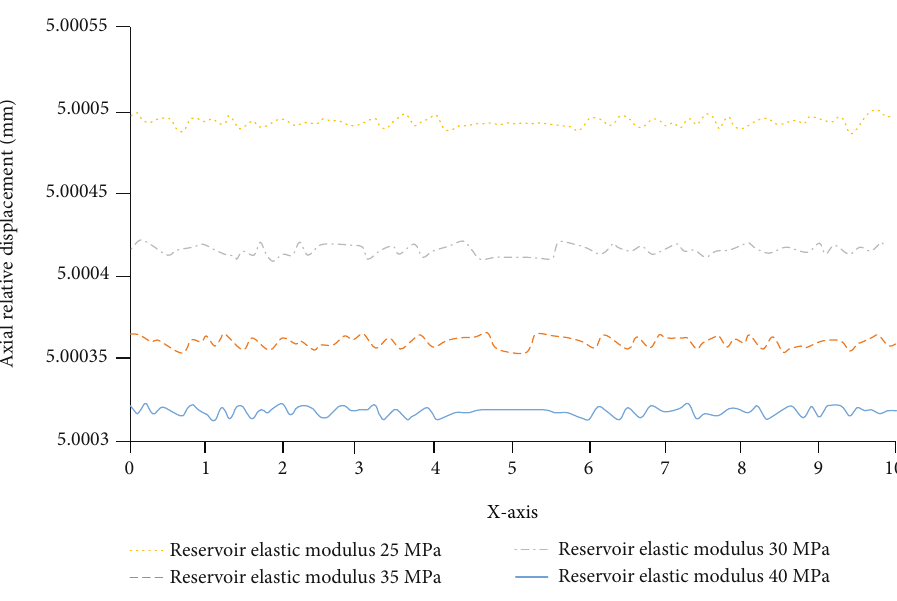
Figure 34: Axial relative displacement of two rock slabs under di ff erent reservoir elastic moduli (60MPa in situ stress).